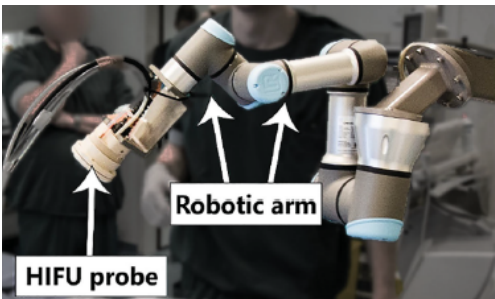
Figure 7. Six-DoF system developed by Groen et al. that treats atherosclerosis with precise HIFU delivery to the arterial wall of the peripheral artery [54].